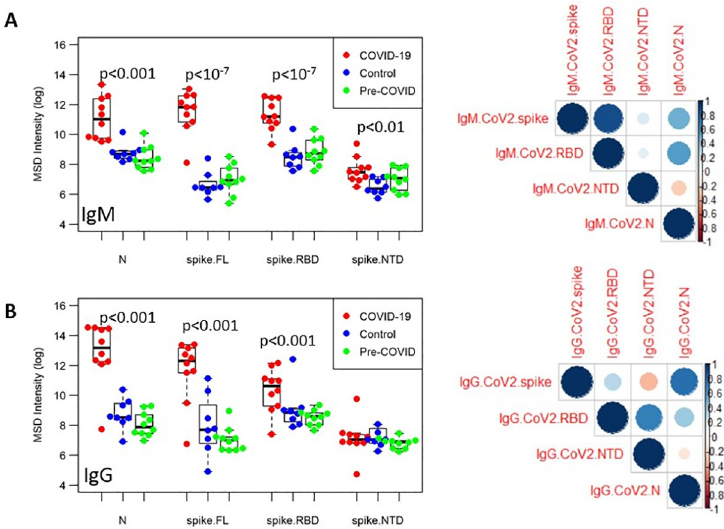
Fig 4. Fine-specificity of SARS-CoV-2 specific antibody responses. The IgM (A) and IgG (B) responses in samples from three groups (COVID-19, red; Control, blue; Pre-COVID, green) was assessed in the multiplex ECLIA platform against SARS-CoV-2 full-length spike protein, spike RBD, spike NTD, and nucleocapsid. Correlation matrices are shown on the right, with the color and size of the circles corresponding to pairwise Pearson correlation coefficient.